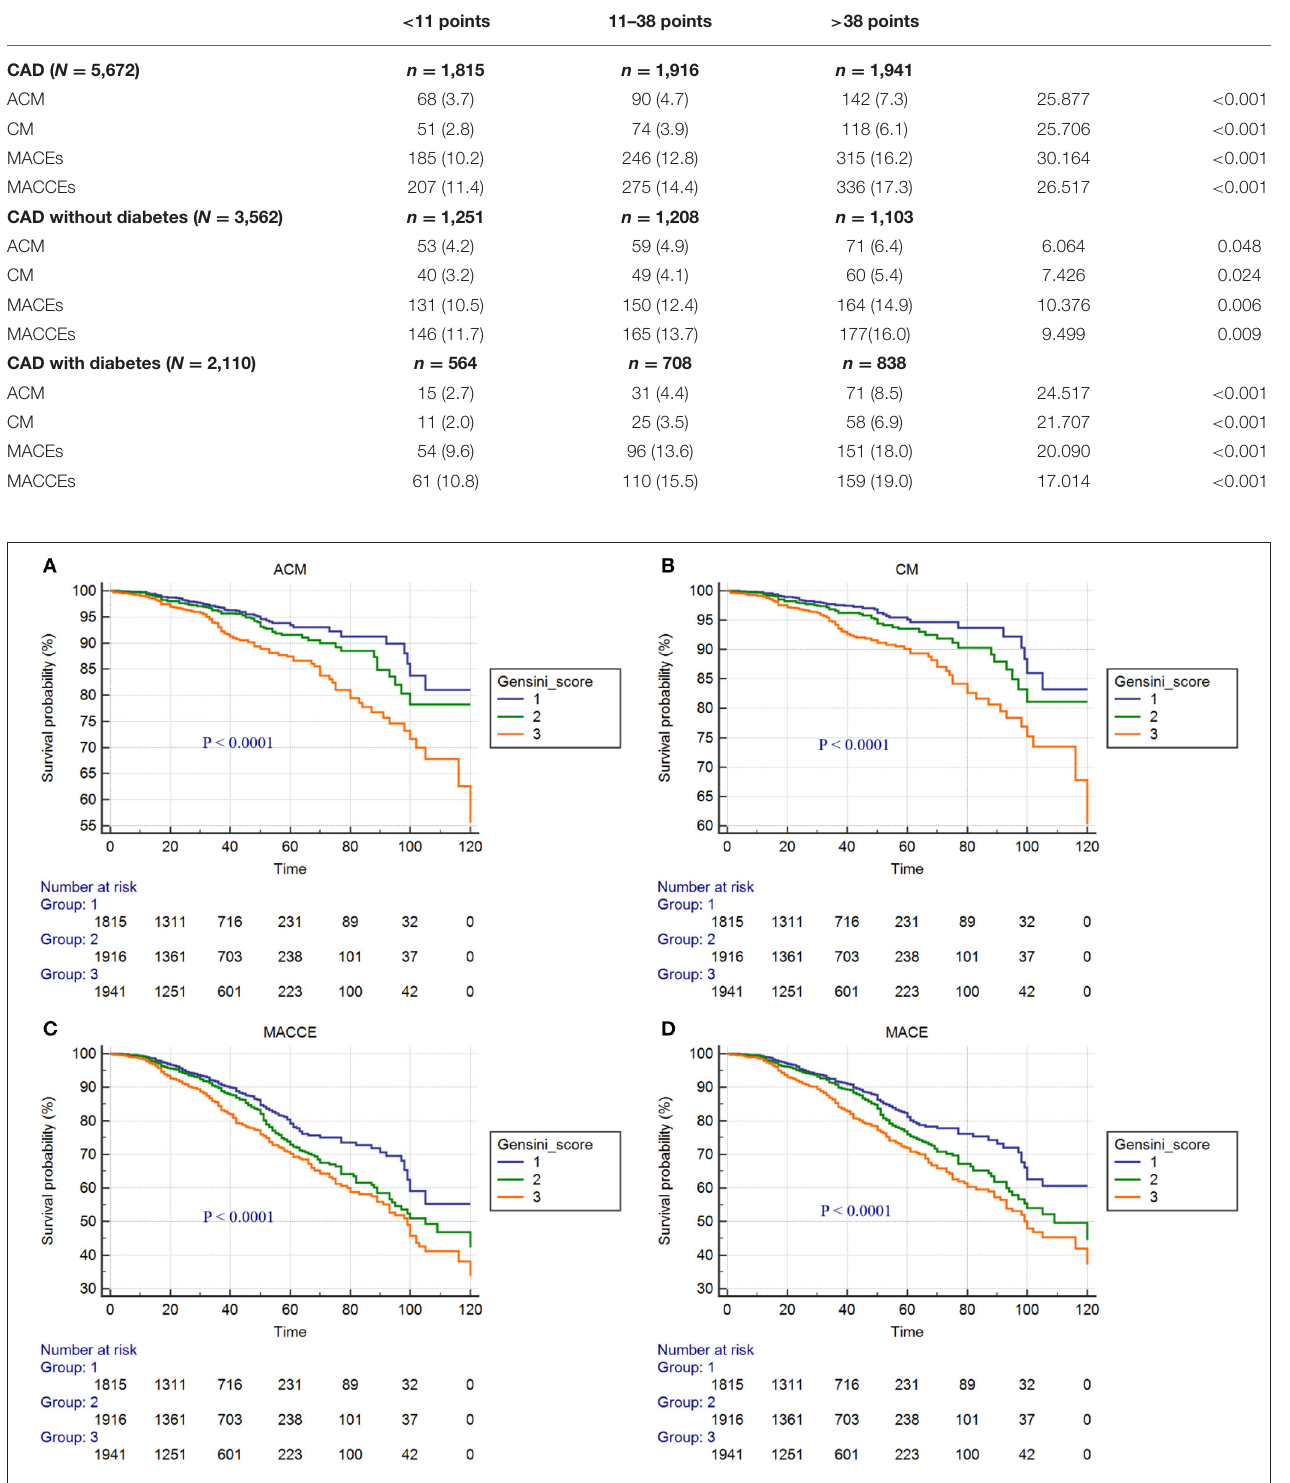
Frontiers in Cardiovascular Medicine |